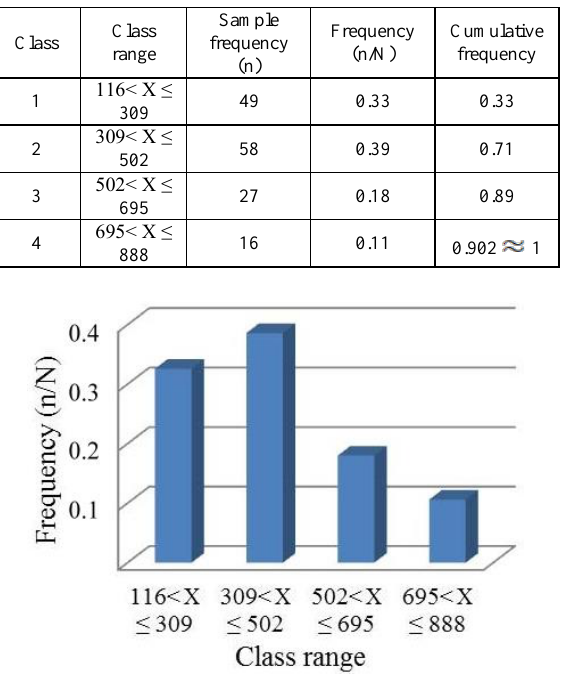
Figure 4. Distribution of